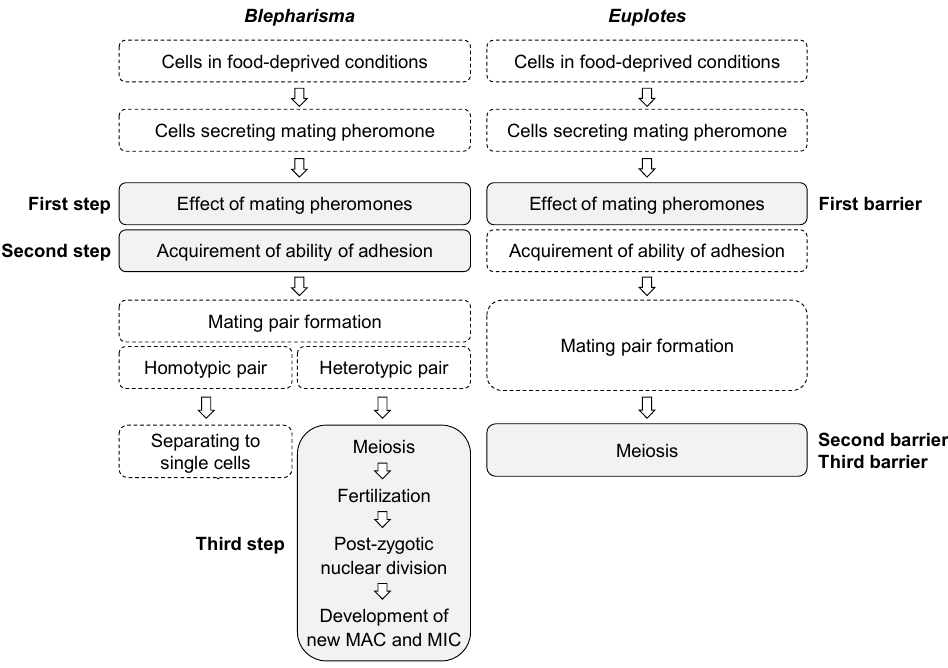
Figure 6. Presumptive steps or barriers that prevent interspecific conjugation in Blepharisma and Euplotes . This figure has been modified after [3], by the addition of a third step in Blepharisma .